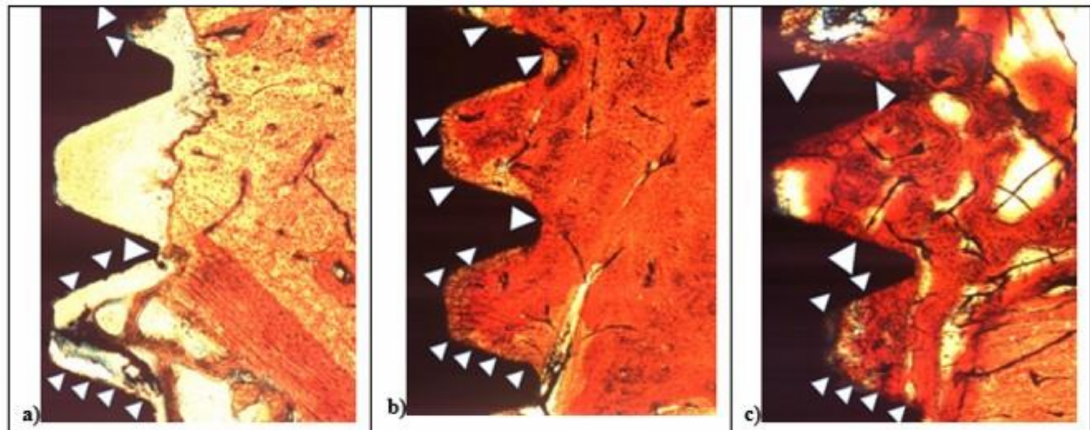
Figure 8. After 15 days histological analysis of SBAE ( a ), L1 ( b ), and L2 ( c ) of the osseointegration healing process at 200 ×